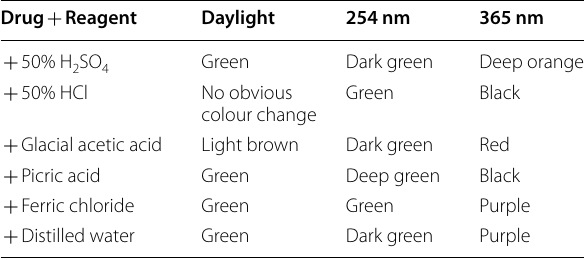
Table 7 Fluorescence analysis of Palisota hirsuta